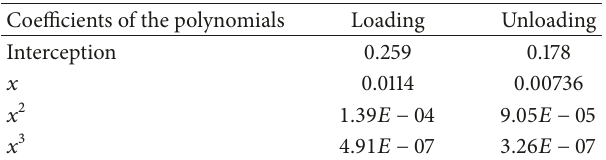
Figure 8: Deflection of protuberant foil thrust bearing with static load. Table 5: Standard error of the polynomials for load and deflection curves of thrust bearing.